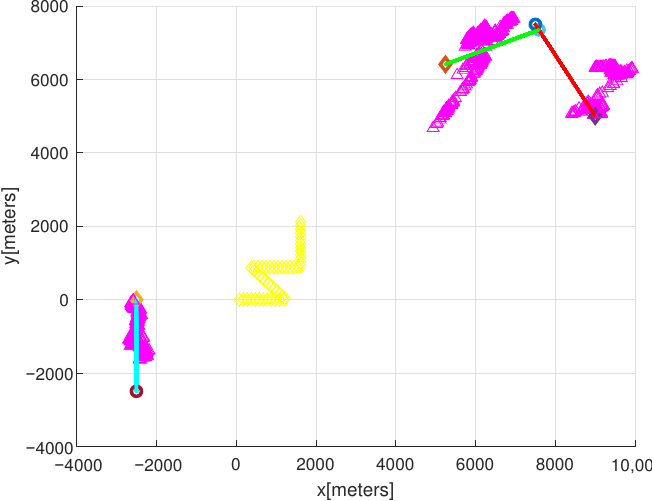
Figure 1. For clear presentation of the observer’s path, this figure simulates the case where there is no interference point. The observer’s path is marked with yellow colors. Target 1 (red) starts from [7500, 7500] and moves with velocity [3, − 5] in m/s. Target 2 (blue) starts from [ − 2500, − 2500] and moves with velocity [0, 5] in m/s. Targets 1 (red) and 2 (blue) are generated at sampling-stamp 0, and target 3 (green) is spawned from target 1 at 30 s. Target 3 (green) moves with velocity [ − 5, − 2] in m/s. We present the direction of target motion using symbols. A circle symbol indicates the start point of a target motion, and a diamond symbol indicates the end point of a target motion. The estimated target position is marked with magenta